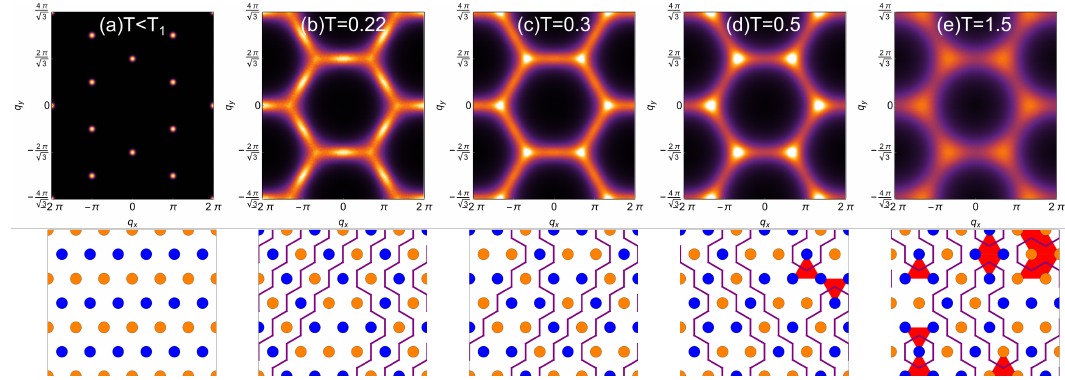
Figure 5: The structure factor of the dipolar TLIAF, together with typical configurations. (a) Below the (cid:112) first order transition there are Bragg peaks at q stripe = ( 0,2 π/ 3 ) and symmetry-related wavevectors, associated with the stripe ordering. (b) Above the transition weight develops around the BZ boundary, (cid:112) but is peaked at q stripe and q tri = ( 2 π/ 3,2 π/ 3 ) , and this is associated with a domain-wall network configuration. (c) Further increasing the temperature results in the peaks at q tri dominating over those at q stripe , and this is associated with a switch from attractive to repulsive string-string interactions. (d) At still higher temperatures the peaks at q tri remain sharp, and the system can be described as a string- Luttinger liquid. (e) Once the temperature becomes comparable with J the peaks at q tri lose their 1 sharpness, and this is associated with the proliferation of defect triangles and the loss of significant